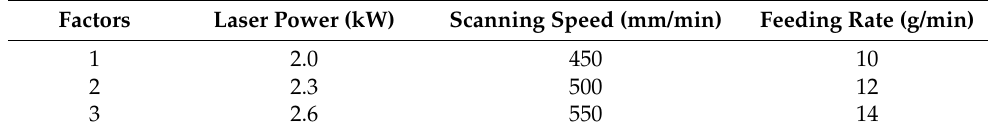
Table 4. Orthogonal process Table 3. Test factor level.